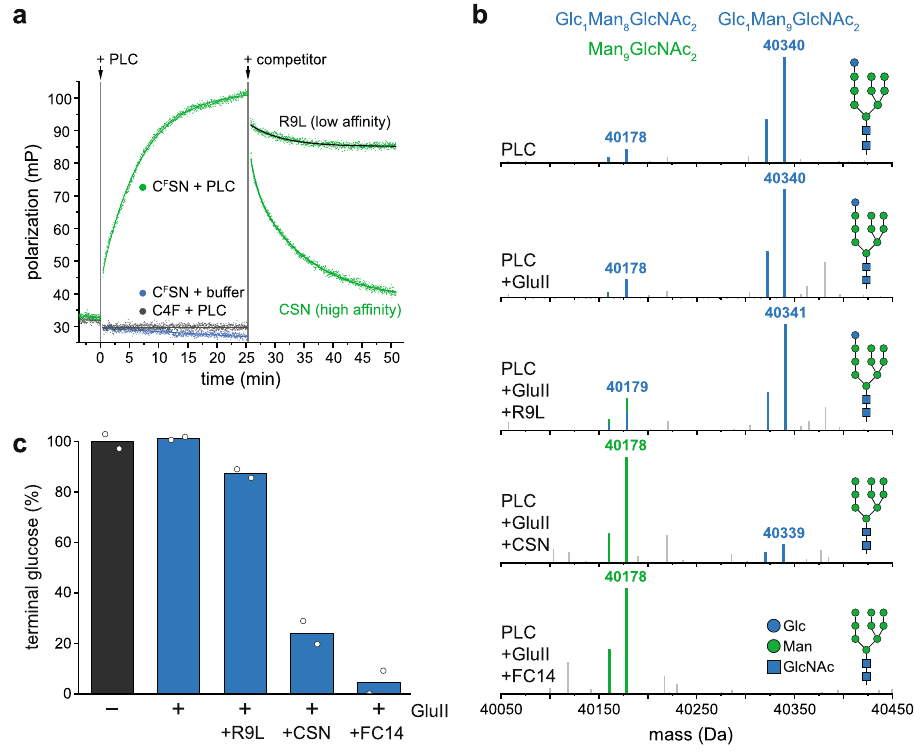
Fig. 3 | Peptide editing and allosterically coupled MHC I glycan processing by GluII in the PLC. a Peptide binding and proofreading of HLA-A*03:01 associated with the PLC reconstituted in lipid nanodiscs (75nM of PLC) monitored by fl uor- escence polarization using equimolar concentrations of fl uorescent reporter peptides: high-af fi nity epitope C F SN (AIFC F SNMTK) or low-af fi nity HLA-B*27:01- restricted epitope C4F (RRYC F KSTEL). For peptide editing, a 2000-fold molar